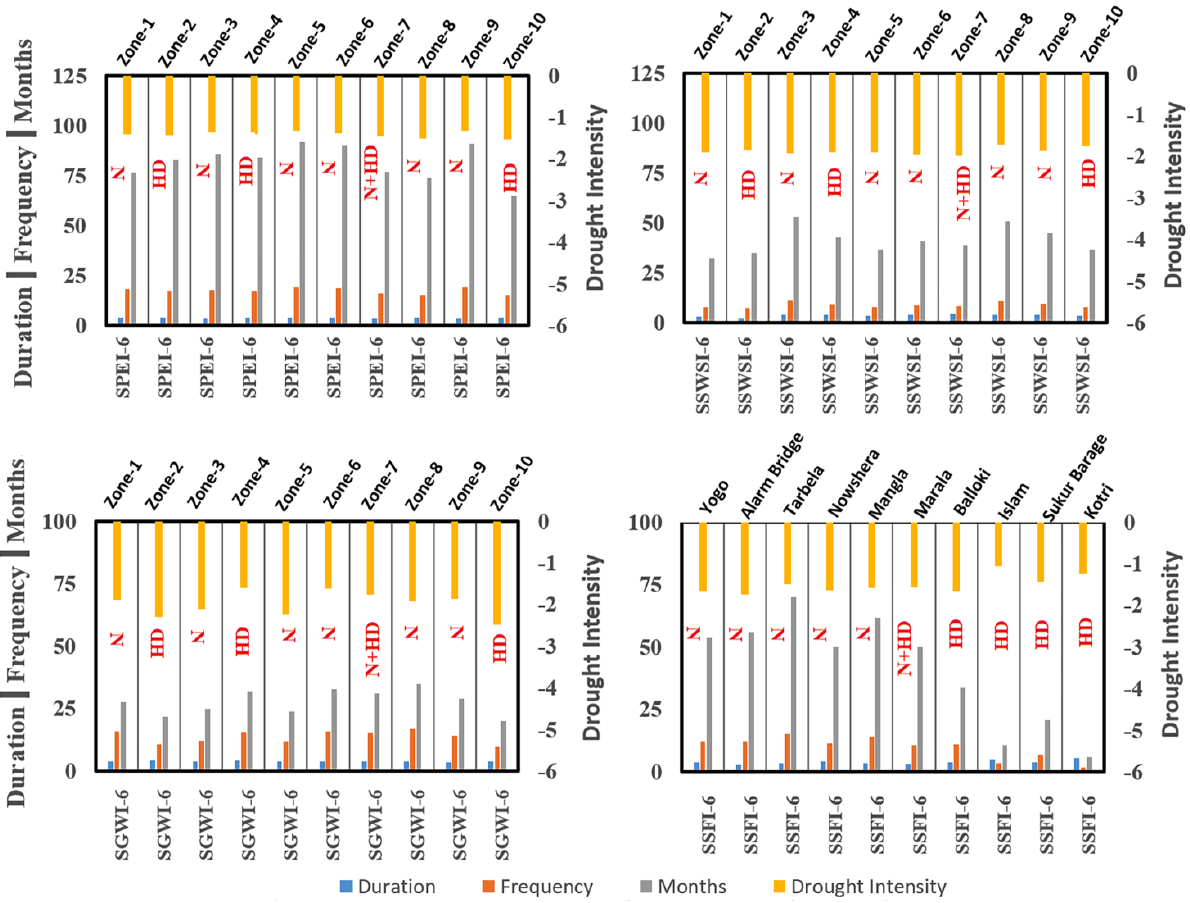
Figure 6. Distribution of hydro-meteorological drought events (duration, intensity, drought months, and frequency) for SPEI, SSWSI, SGWI and SSFI, in natural (N) and human-disturbed (HD) AEZs. (Note: SPEI, TWSI, and SGWI were computed over 10 different AEZs, whereas SSFI was derived for 10 stream gauging stations distributed in different zones). Table 2. Drought termination characteristics in different zones.